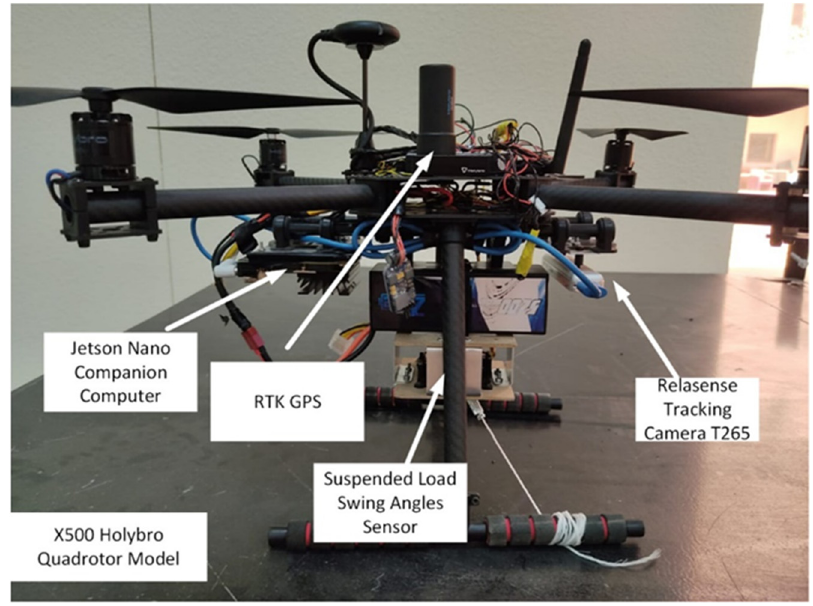
Figure 6. X500 Holybro quadcopter with a jetson computer, an RTK GPS, and a relasense camera installed for indoor and outdoor testing.